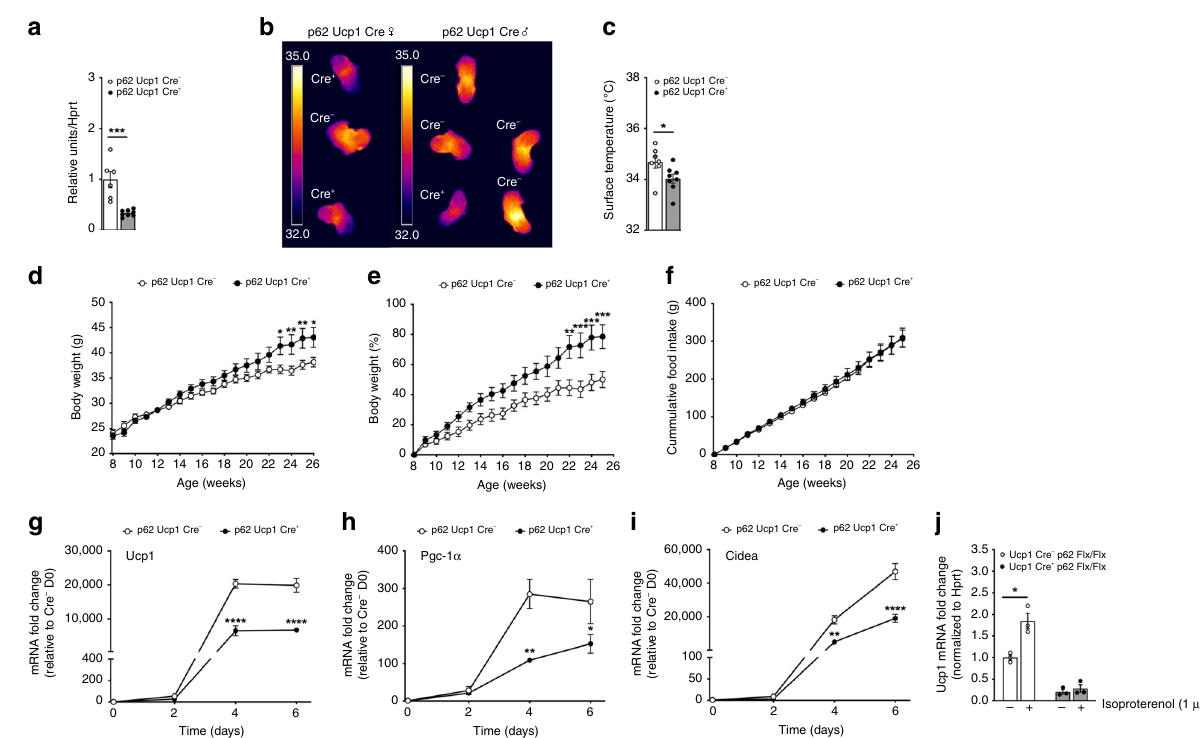
Fig. 4 Impaired BAT function in p62 fl x/ fl x Ucp1-Cre mice. Expression of p62 in BAT of p62 fl x/ fl x Ucp1-Cre negative (Cre − ) or p62 fl x/ fl x Ucp1-Cre positive (Cre + ) mice ( a ), infrared thermographic imaging in female and male mice ( b ) and surface temperature ( c ) of 7-d-old p62 fl x/ fl x Ucp1-Cre − or p62 fl x/ fl x Ucp1- Cre + mice. Body weight ( d ), body weight change ( e ), and cumulative food intake ( f ) of HFD-fed p62 fl x/ fl x male Ucp1-Cre − or p62 fl x/ fl x Ucp1-Cre + mice. Gene expression of Ucp1 ( g ), Pgc-1 α ( h ) and Cidea ( i ) and isoproterenol-induction of Ucp1 mRNA expression ( j ) in BAT primary cells harvested from 6- to 8- wk-old male p62 fl x/ fl x Ucp1-Cre − or p62 fl x/ fl x Ucp1-Cre + mice, during 6 d of differentiation. Sample sizes are ( a ) n = 6/8 mice, ( b ) n = 3/5 mice, ( c – e ) n = 7/8 mice. f cumulative food intake was assessed per cage in n = 4/4 cages containing n = 7/8 mice; 2 cages ( n = 1/1) were excluded because mice shredded food. g – i BAT primary cells were harvested from p62 wt or Ucp1-cre p62 fl x/ fl x mice, plated with equal number of cells in n = 3 wells each genotype and individually differentiated into mature brown adipocytes. Target gene expression was then measured in n = 3 individually differentiated wells each genotype with two technical replicates each well. j BAT primary cells were harvested from p62 wt or Ucp1-cre p62 fl x/ fl x mice, plated with equal number of cells in n = 3 wells each treatment group and individually differentiated into mature brown adipocytes. Target gene expression was then measured in n = 3 individually differentiated wells each treatment group with two technical replicates each well. Data in ( d – i ) are analyzed using two-way ANOVA using time and genotype as covariate and using Bonferroni post hoc multiple comparison to test for differences in individual time points. Data in ( a ), ( c ), and ( j ) were analyzed using two-sided two-tailed t -test. Data represent mean± SEM. * p < 0.05; ** p < 0.01; *** p <0.001; **** P < 0.0001. Exact p -values are ( a ) p = 0.000424; ( c ) p = 0.0428; ( d ) d23 p = 0.0286, d24 p = 0.0082, d25 p = 0.0070, d26 p = 0.150; ( e ) d22 p = 0.0019, d23 p = 0.0006, d24 p =